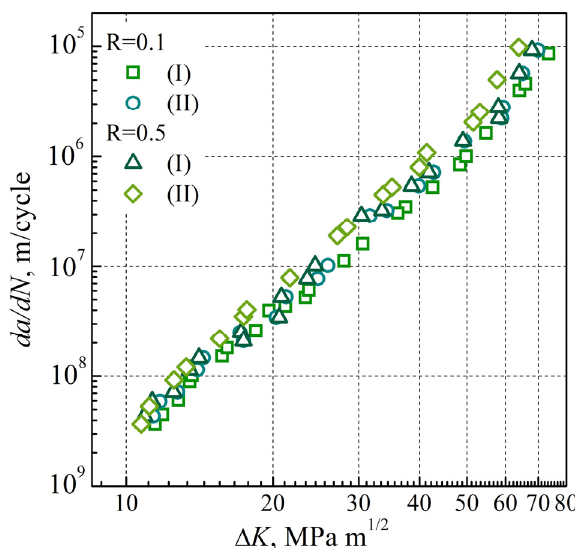
Figure 7. Dependences of the FCG rate on the SIF range ( da / dN — ∆ K ) obtained for 17H1S steel in the AR state at values of the stress ratio of 0.1 ((I),(II)) and 0.5 ((I),(II)) on specimens cut from the stock pipe close to its outer (I) and inner (II) surfaces.